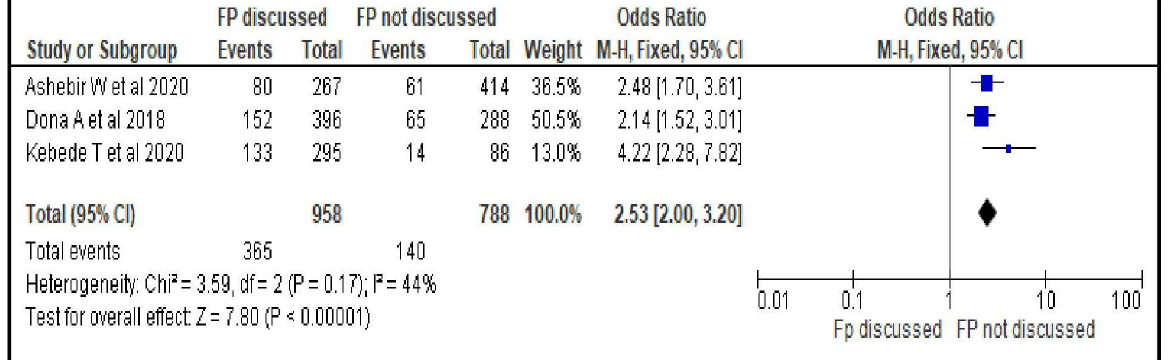
Fig 6. Association between discussion about family planning with partner and modern contraceptive uptake during postpartum period, 2021.